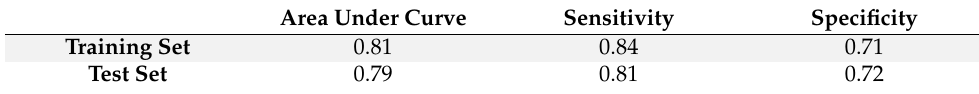
Table 10. Performance of the proposed method for notch detection—adapted from [39]. Area Under Curve Sensitivity Specificity Training Set